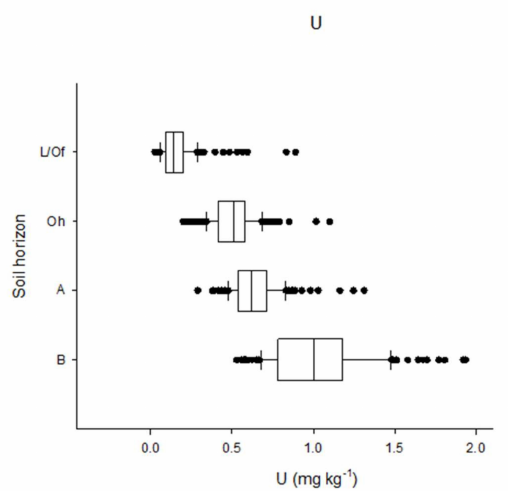
Figure 2. Boxplot showing depth profile of U in the Wüstebach catchment.